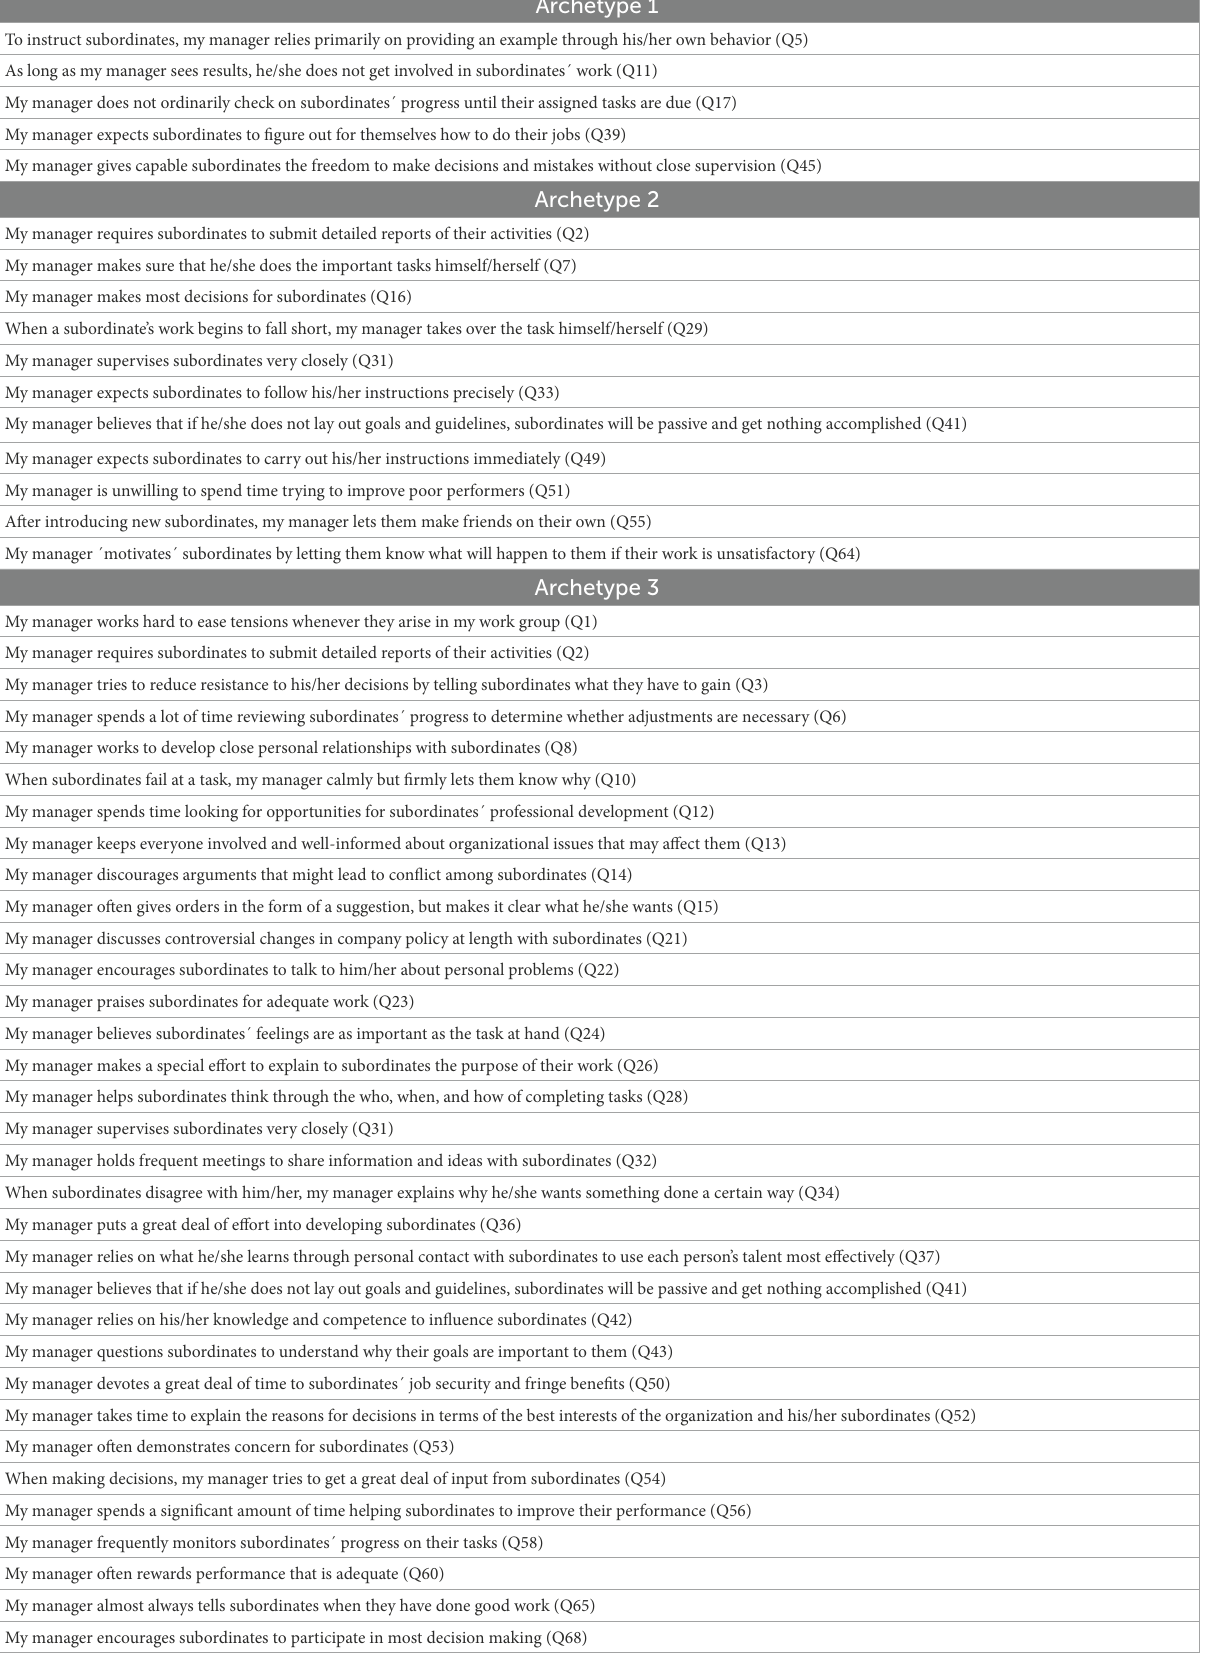
TABLE 2 46 Behavioral questions used to classify leaders, along with their archetype